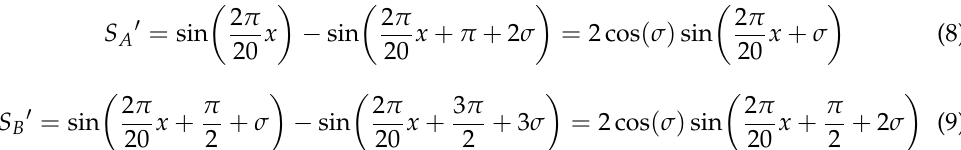
Figure 3. Phase arrangement of longitudinal Moiré fringe signals received by photoelectric device.